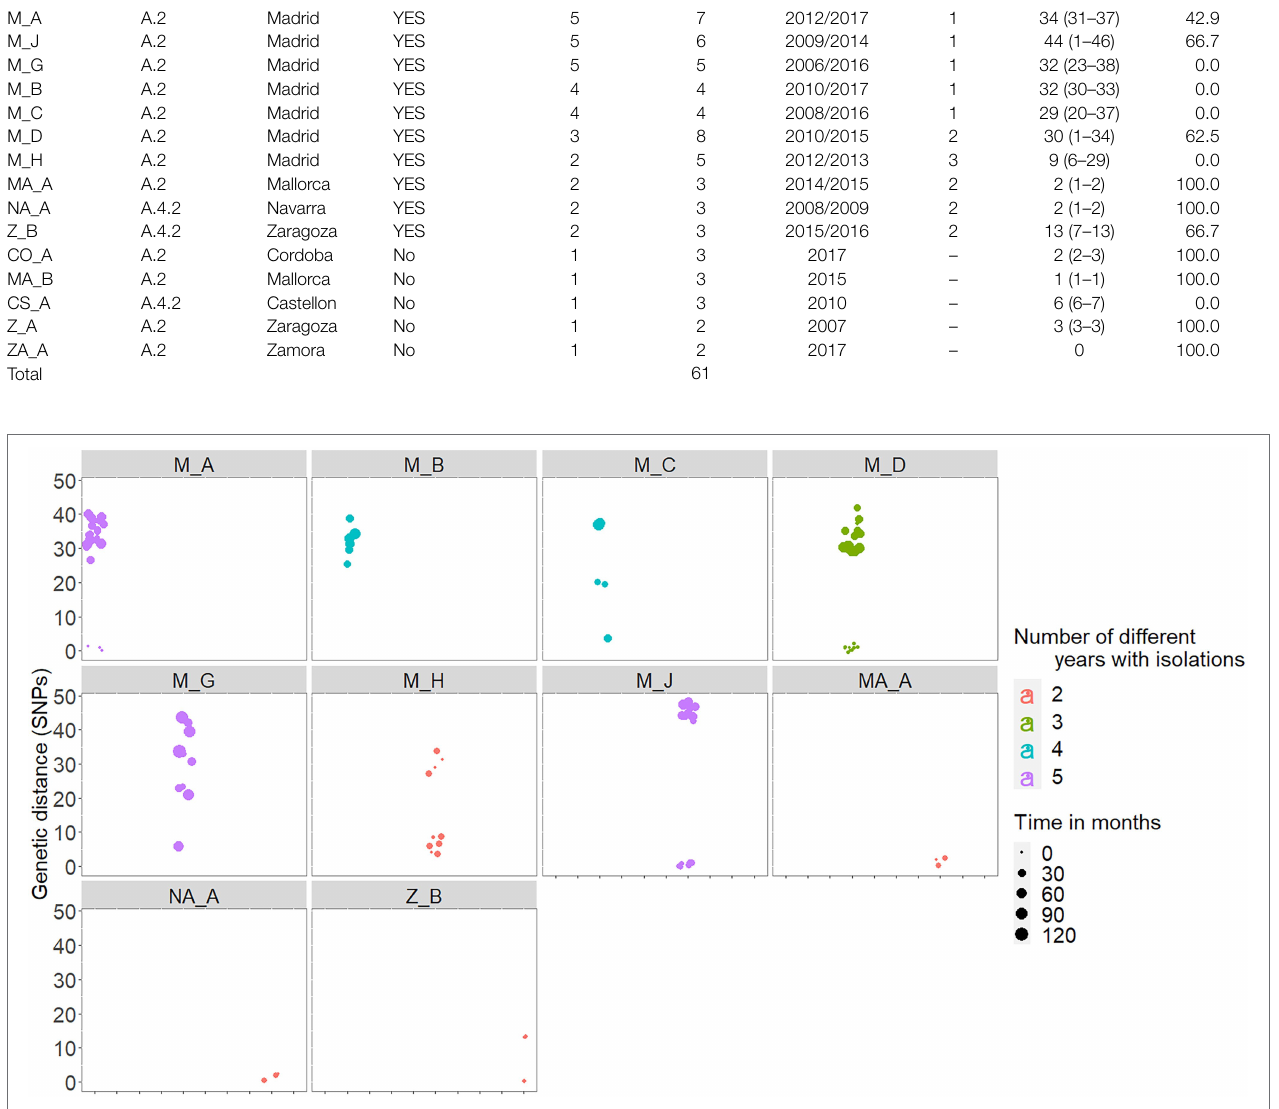
FIGURE 4 | Within-herd pairwise genetic distances among isolates recovered in the 10 chronically infected herds. Genetic distances are colored based on the number of different years with M. bovis isolates (between 2 and 5 different years), and the size represents the number of months elapsed between each pair of isolates.